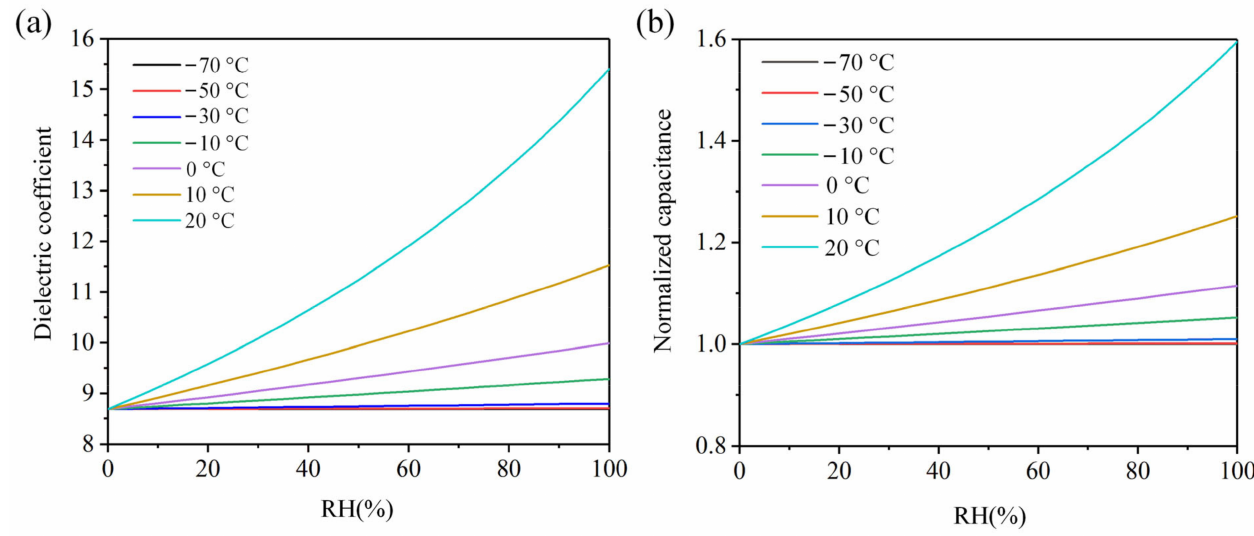
Figure 5. ( a ) Dielectric coefficient and ( b ) normalized capacitance under different T and RH